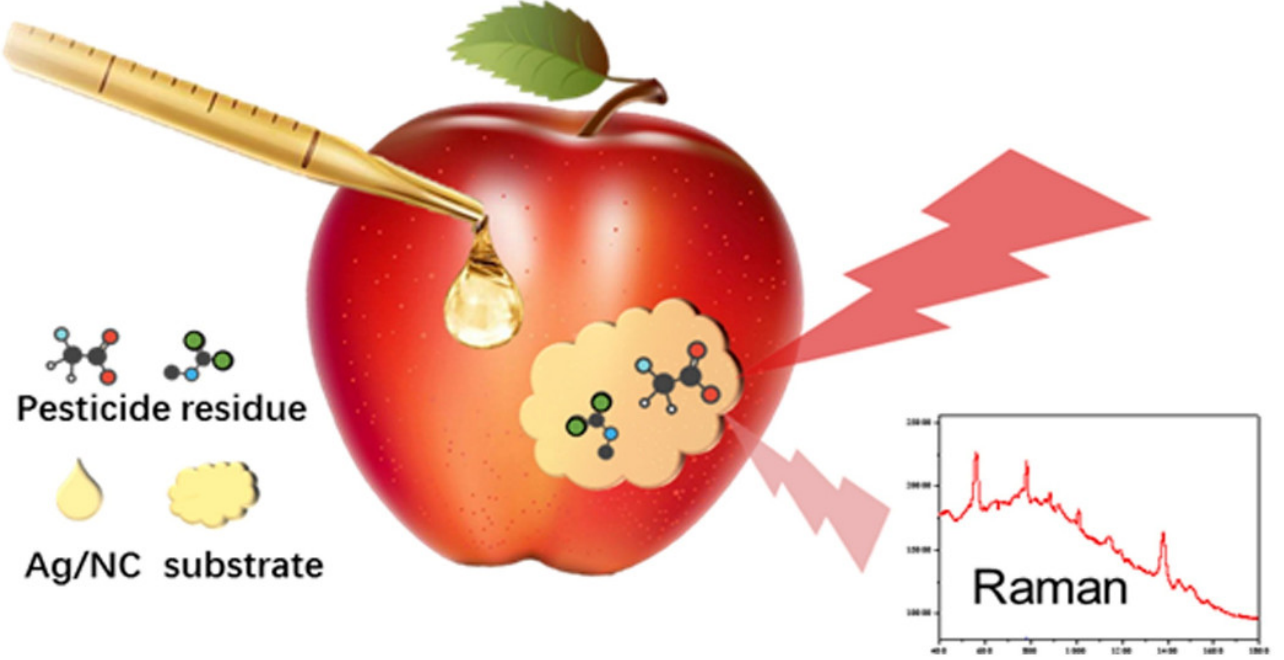
Figure 4. SERS application for rapid in-situ pesticide detections in fruits and vegetables. The nanocellulose decorated with Ag nanoparticles (Ag/NC) substrate was used to detect pesticides (thiram and thiabendazole) on apple and cabbages samples. Reproduced from [62] Carbohydrate Polymers, Copyright (2019), with permission from Elsevier.